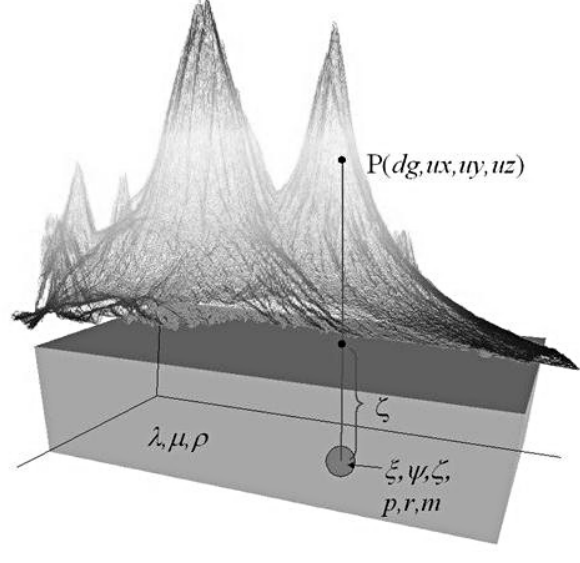
Fig. 1. Elastic-gravitational model (Tiede, 2005).